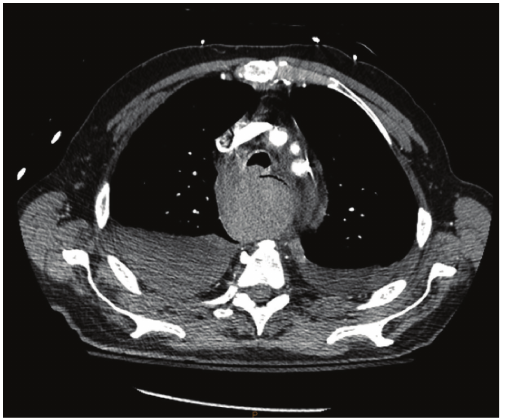
Figure 1: Posterior Mediastinal Hematoma measuring 5.9cm × 5.8cm × 21 cm, identified via CT scan upon patient presentation to MGH.